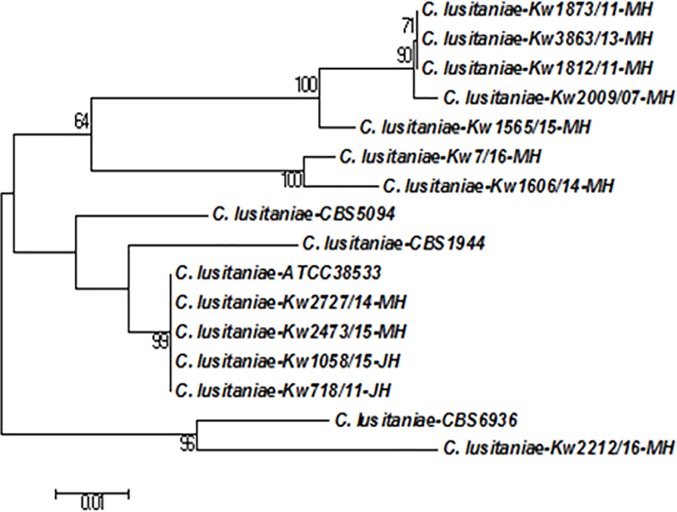
Neighbor-joining phylogenetic tree based on ITS region of rDNA sequence data for clinical C. lusitaniae strains isolated from nine neonates from Hospital A in Kuwait together with four reference strains.The sequence data for C. lusitaniae strains isolated from 2 neonates from Hospital B during the study period and one archived C. lusitaniae strain isolated previously from a neonate from Hospital A were also used for comparison purpose. The numbers on the node branches are bootstrap frequencies.